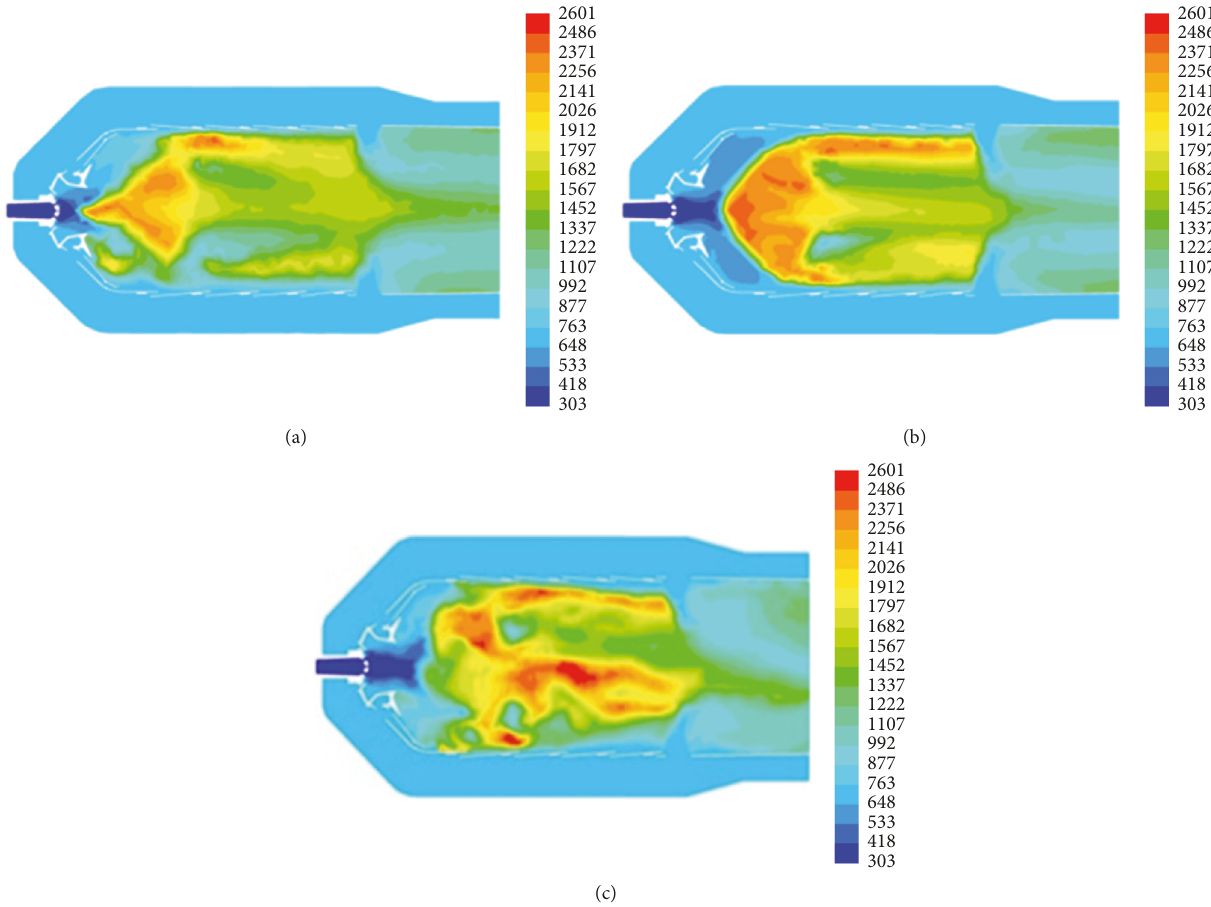
Figure 8: Temperature contours in the longitudinal section of the combustor, K: (a) variant 1; (b) variant 2; (c) variant